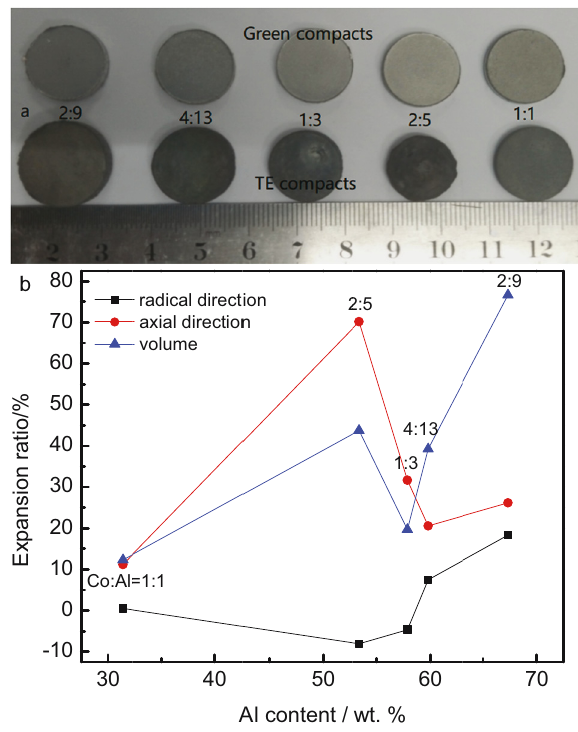
Figure 3: Expansion behaviors of porous intermetallics with different Co/Al molar ratios: ( a ) macroscopic, ( b ) volume, axial, and radial direction expansion.